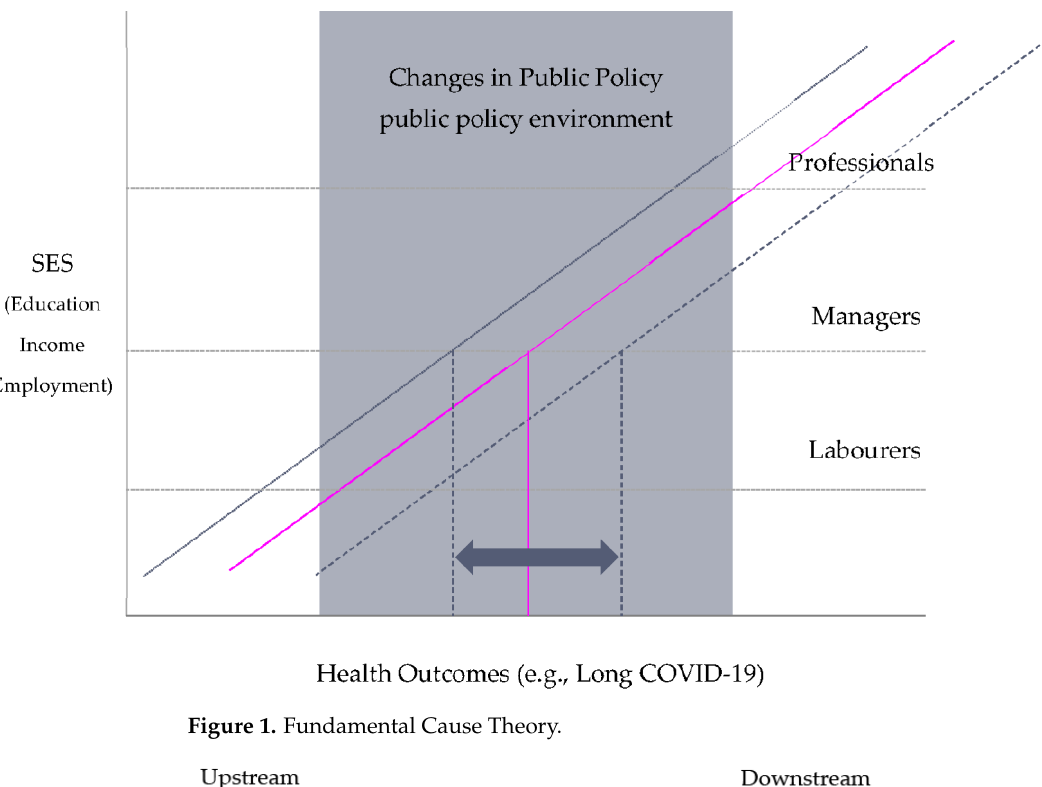
Figure 1. Fundamental Cause Theory.